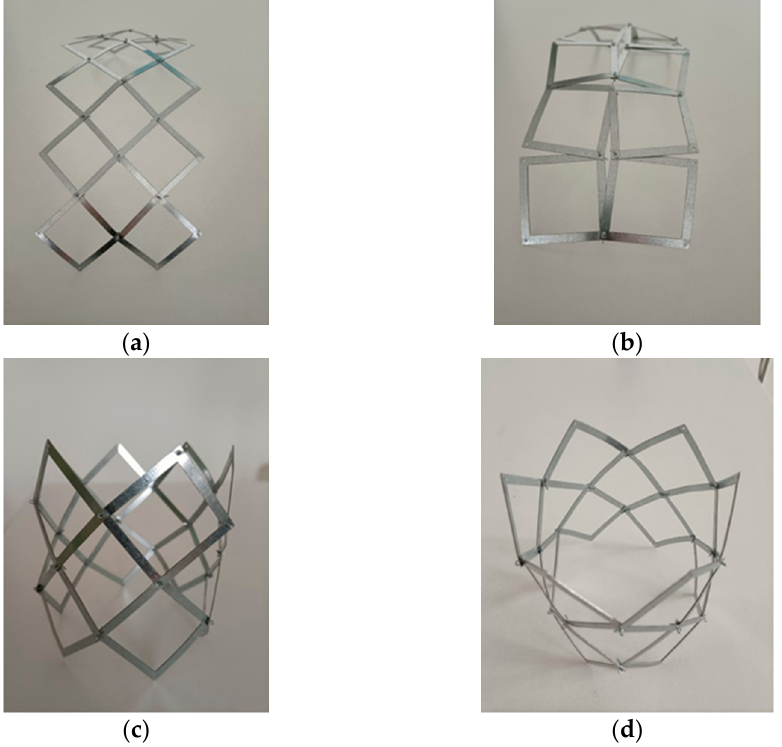
Figure 15. Planar construction of 6 × 2 square frames of a non-elastic material ( a , b ) and a tubular structure ( c , d ) after joining them, open positions ( c ) and closed positions ( d ).